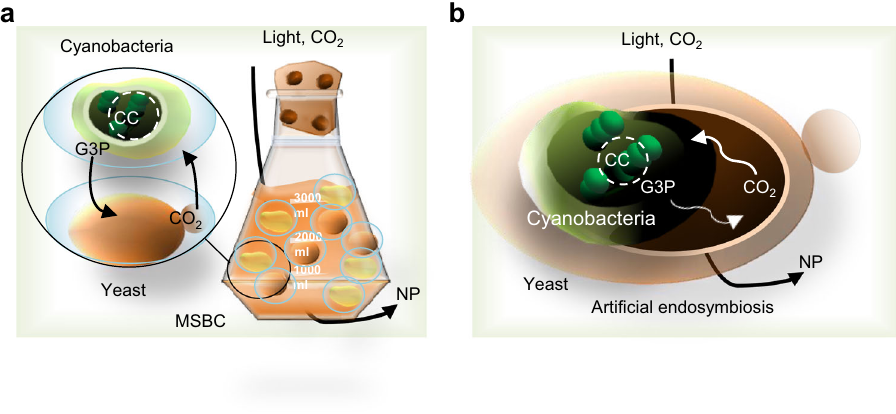
Fig. 4 | Arti fi cial microbial communities to promote circular acetyl-CoA pro- duction in yeast. a An MSBC is created in polymeric microcapsules by encapsula- tion of subpopulations of cyanobacteria and yeast. Phototrophic cyanobacteria capture the CO 2 in the presence of light. The produced G3P is converted to the required carbon for production of metabolites, including NPs, in yeast. CO 2 pro- duced by the yeast is reused by the autotrophic partner. b Arti fi cial endosymbiosis.